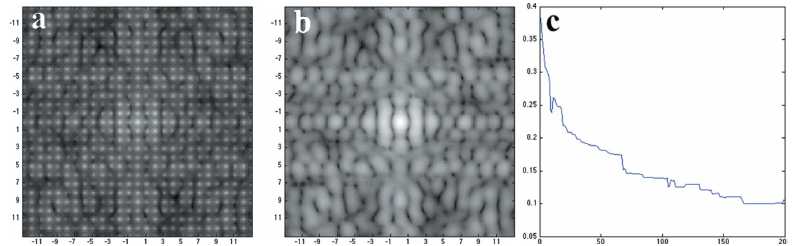
Figure 3 Recovery of the molecular shape transform. ( a ) Accumulated diffraction patterns from 200 crystaldiffractionpatternsshowing Braggspots;( b ) Therecoveredsingleunit-cell scattering pattern(the‘moleculartransform’);( c ) the R factorisprogressivelyreducedasthenumberof patterns increases. The Miller indices are marked in the patterns, where k max = 13.